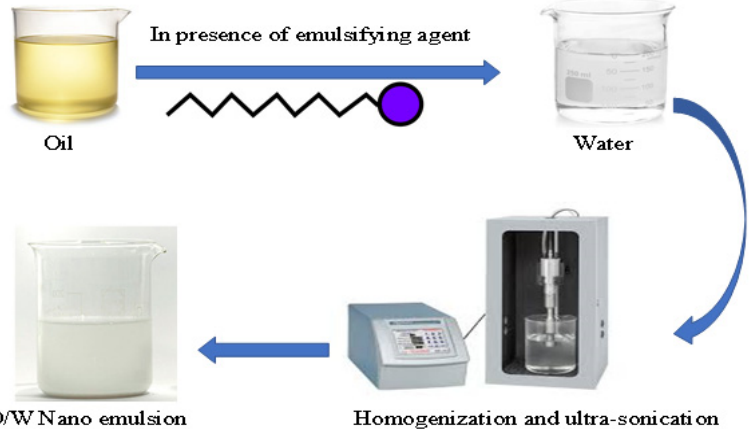
Figure 9. A diagram illustrating preparation of the oil/water nanoemulsion preparations.